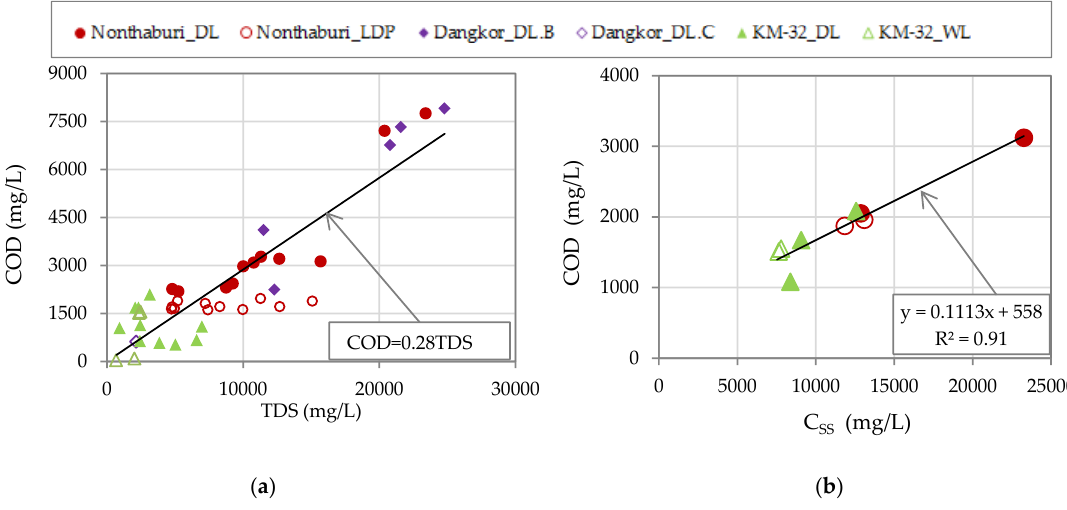
Figure 5. ( a ) Relationship between COD and TDS; ( b ) Relationship between COD and suspended solids concentration (C SS ).